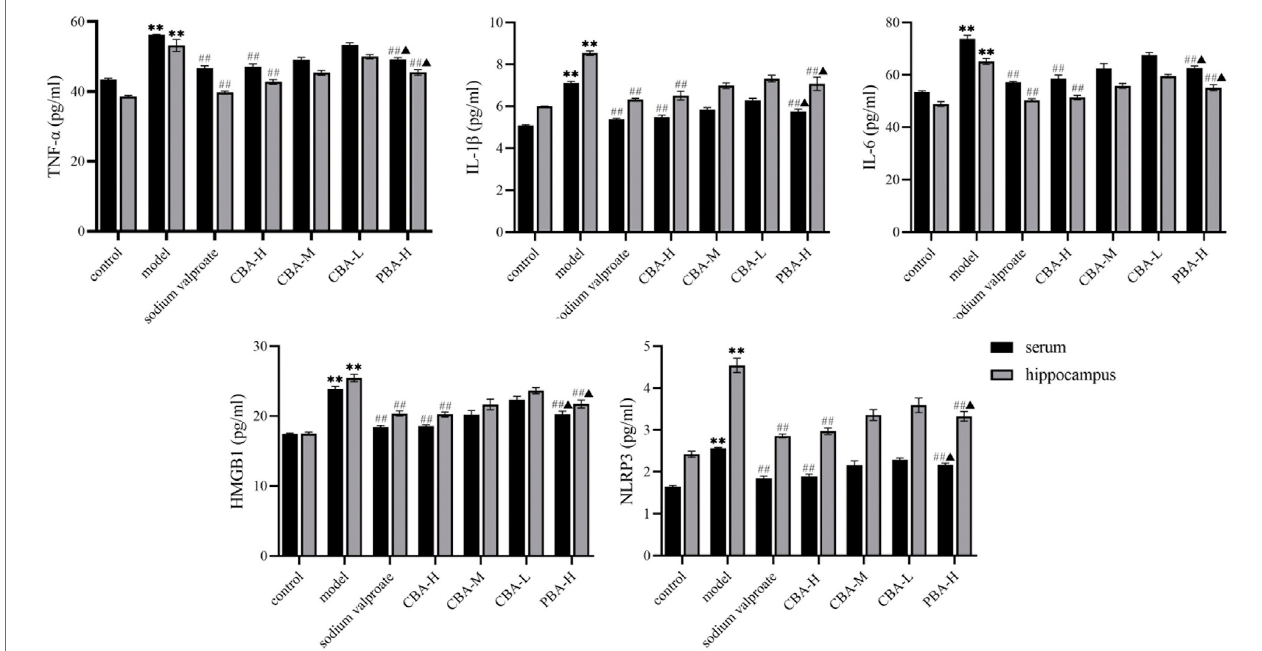
FIGURE4| CBAinhibited therelease ofpro-in fl ammatorycytokines inFSratserumand hippocampus.Dataofpro-in fl ammatory cytokinecontentswereanalyzed asthemean±SEM.** p < 0.01comparedtothatofthecontrolgroup; ## p < 0.01comparedtothatofthemodelgroup; ▲ p < 0.05comparedtothatoftheCBA-Hgroup.